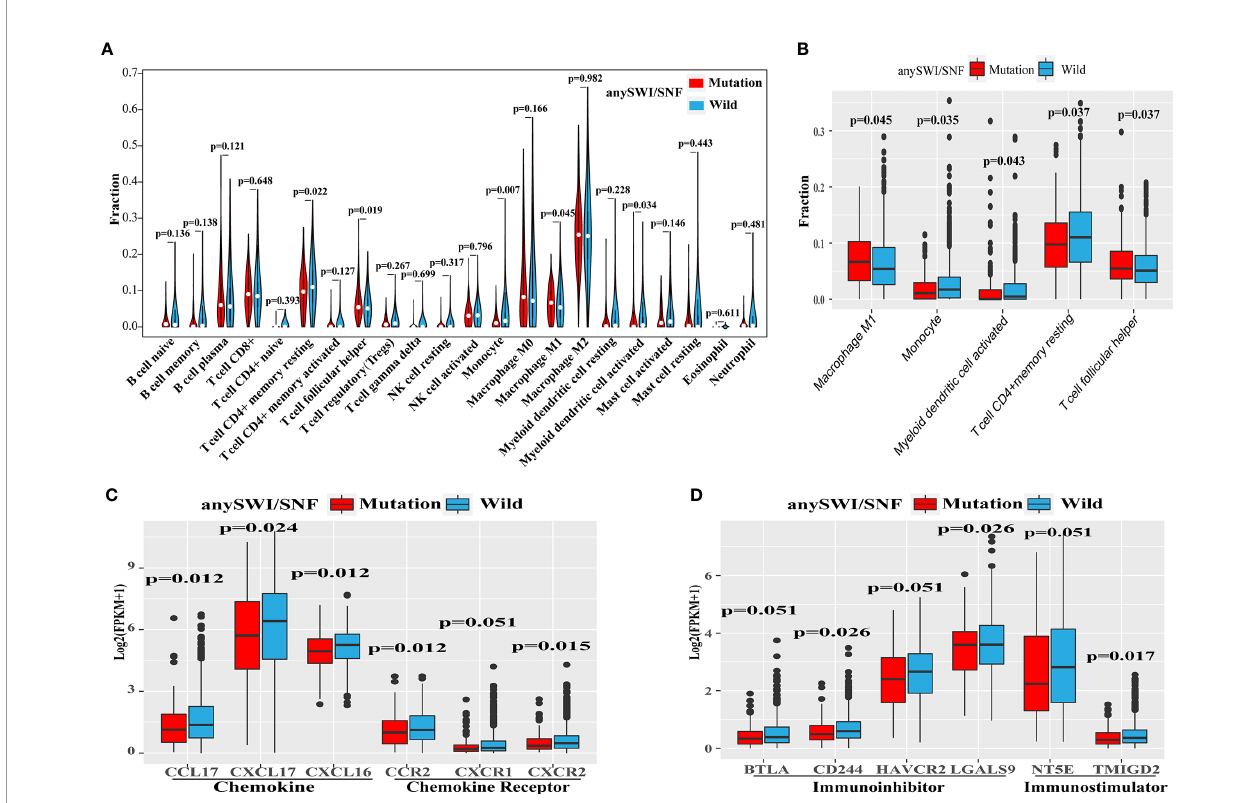
FIGURE 4 | Altered immune microenvironment in SWI/SNF mutation patients. (A) Violin plot of the relative in fi ltration of 22 immune cell types in The Cancer Genome Atlas (TCGA) cohort. (B) Immune in fi ltration of monocytes or dendritic cells according to the human switch/sucrose nonfermentable (SWI/SNF) complex mutation status of the TCGA cohort. (C, D) Expression of chemokines or chemokine receptors (C) and immunoinhibitors or immunostimulators (D) according to the SWI/SNF complex mutation status of the TCGA